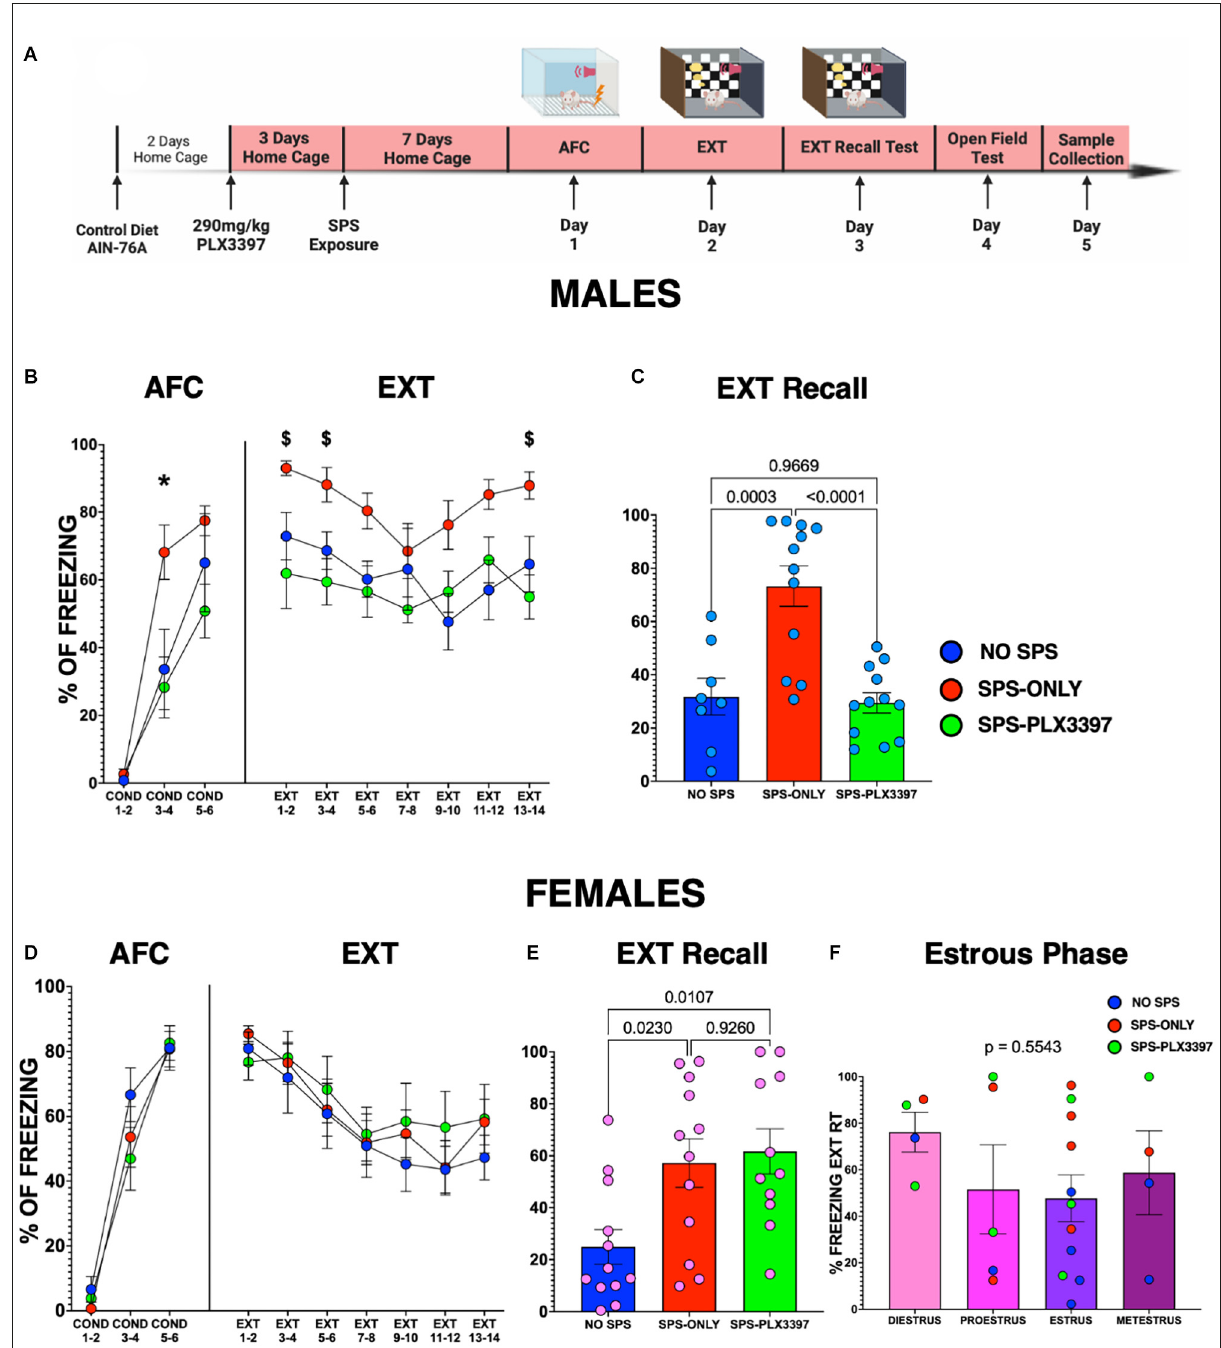
FIGURE1 PLX3397 prevents SPS-induced impaired fear extinction in male, but not in female rats. (A) Experimental timeline. (B) Percent freezing of male rats during auditory fear conditioning (AFC), and extinction (EXT). *Denotes SPS-only is different from the other groups, p < 0.05. $ Denotes SPS-only is different from SPS-PLX3397 group, p < 0.05. (C) Percent freezing of male rats during the extinction recall test ( n = 8 NO SPS, n = 12 SPS-ONLY, n = 12 SPS-PLX3397 males). (D) Percent freezing of female rats during auditory fear conditioning, and extinction training. (E) Percent freezing of female rats during the extinction recall test. (F) Percent freezing during the extinction recall test of female rats grouped by their estrous cycle phase at sacrifice ( n = 12 NO SPS, n = 12 SPS-ONLY, n = 11 SPS-PLX3397 female rats; One-way ANOVA, Tukey’s multiple comparisons test).